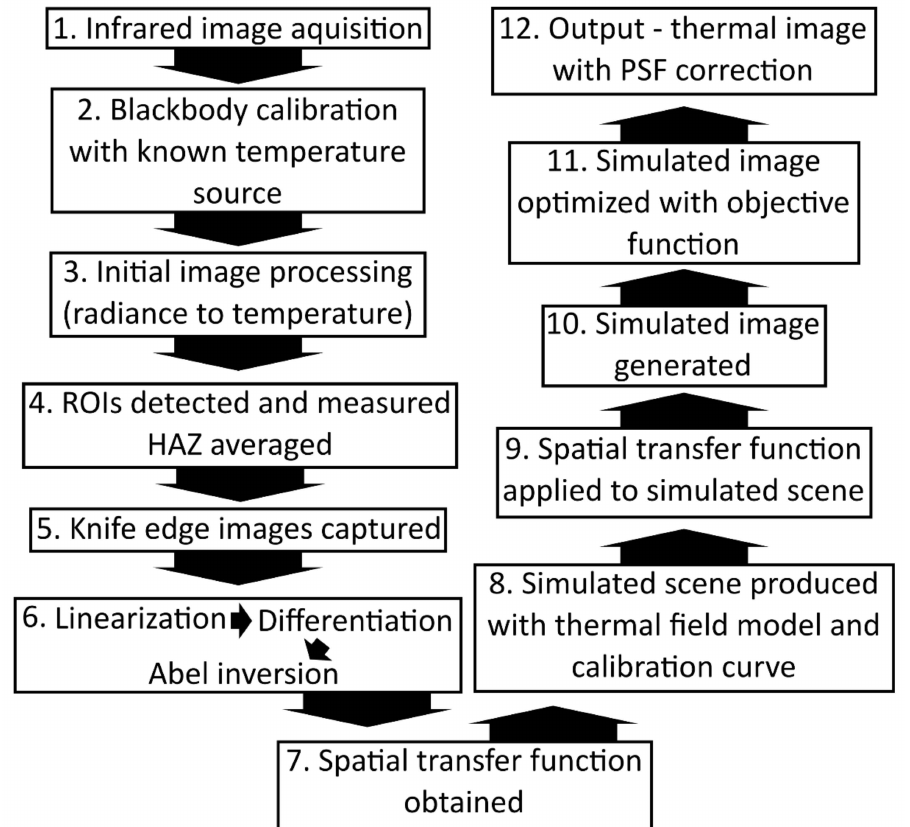
Figure 1. A block diagram detailing the steps involved from image acquisition to the final corrected